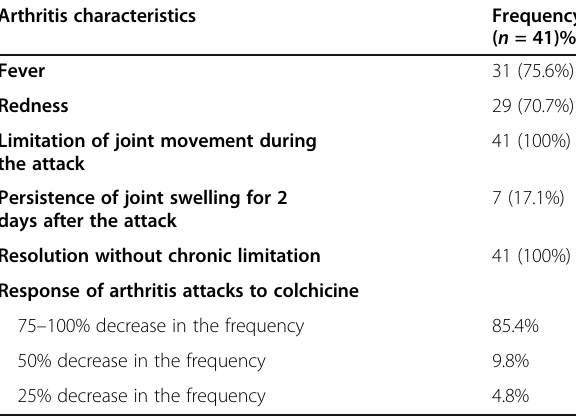
Table 5 Clinical characteristics of the arthritic attacks in FMF arthritis patients and response to colchicines treatment Arthritis